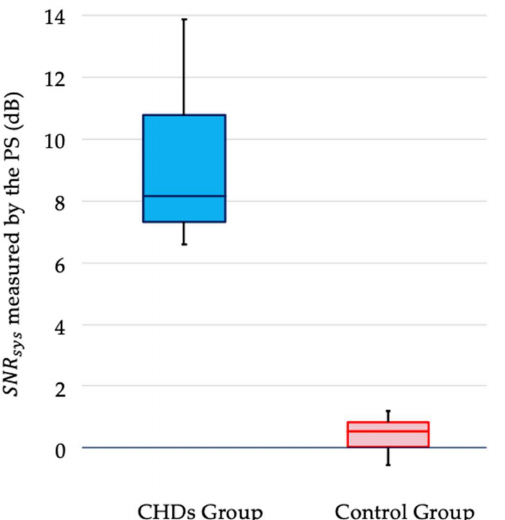
Figure 5. The signal-to-noise ratio ( SNR sys ) of a systolic murmur in nine patients with congenital heart defects (CHDs) and nine healthy neonates. The SNR sys of systolic murmur was significantly higher in patients with CHDs than in healthy neonates ( p < 0.01).